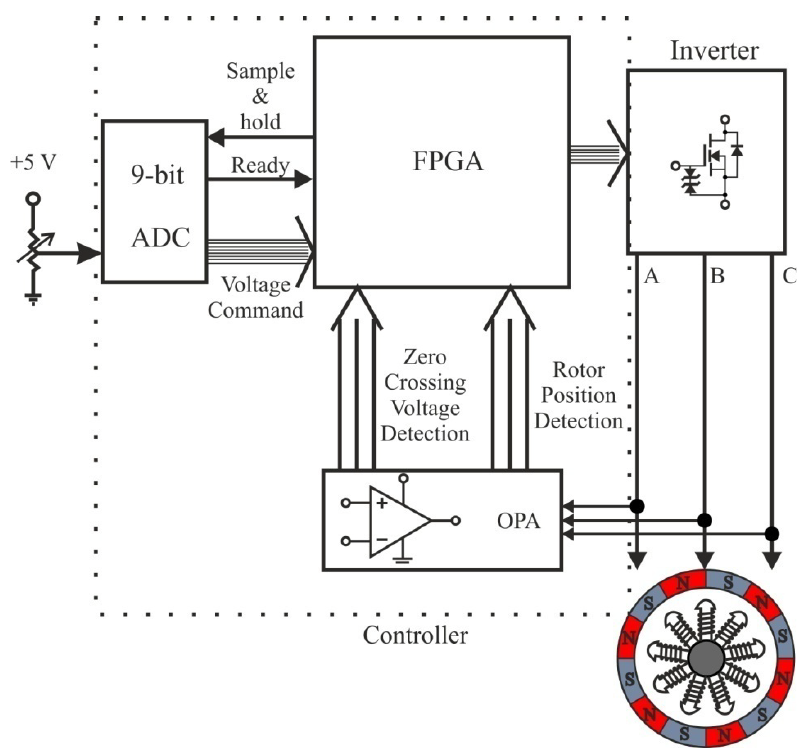
Figure 23. Block diagram of the FPGA-based drive for DVD spindle applications